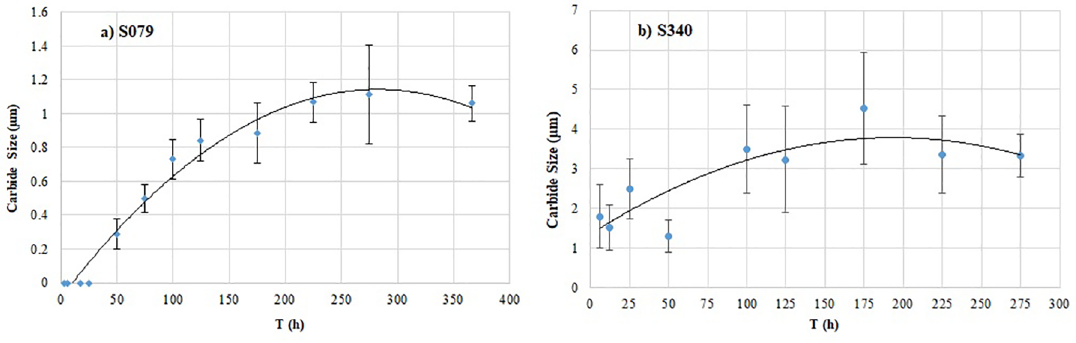
Figure 3. Size of carbides. Measurements carried out from the largest